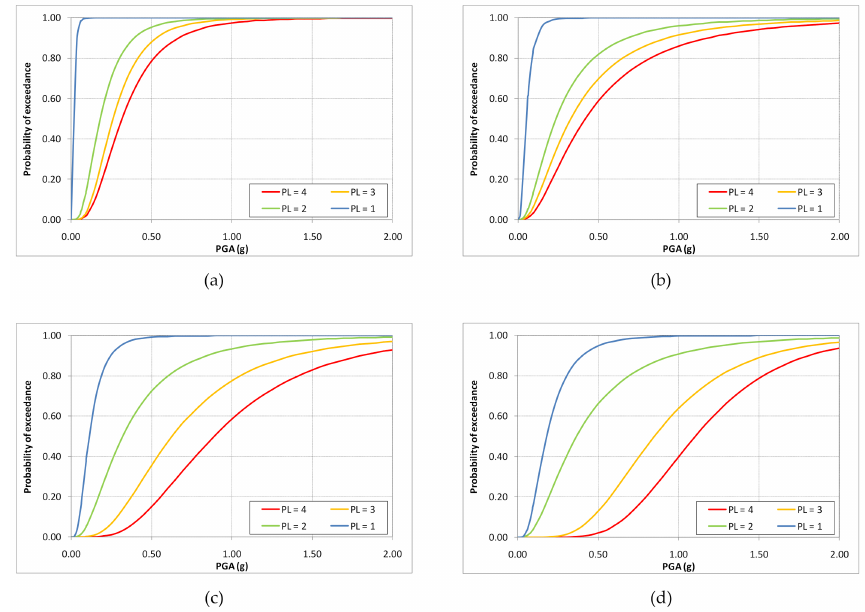
Figure 8. Fragility curves of the building under study, in its current state ( a ) and with different retrofitting techniques: concrete jackets (CJ) ( b ), RC walls (RCW) ( c ), and RC walls and steel jackets (RCW–SJ) ( d